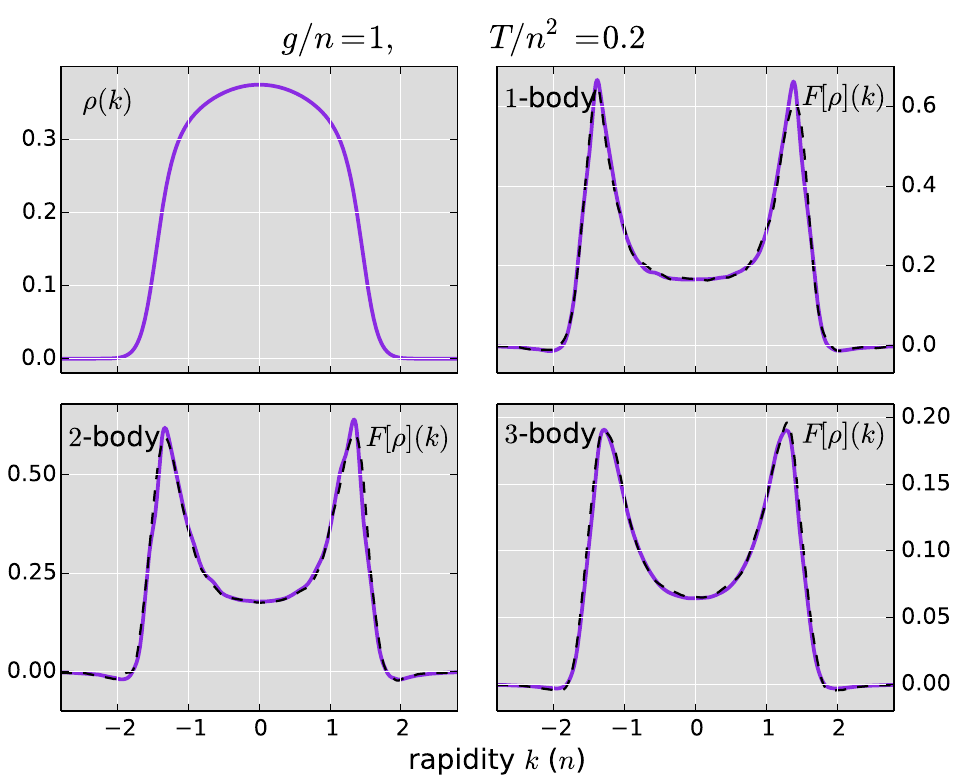
Figure 1: The rapidity distribution ρ ( k ) of the thermal state at temperature T = 0.2 n 2 , with dimensionless repulsion strength g / n = 1, is shown in the top left panel. The other three panels show the corresponding functional F [ ρ ]( k ) com- puted numerically using Eq. (8), for K = 1,2,3 respectively. The purple line is ob- tained by summing over 10 5 pairs of Bethe states with an average number of atoms N (cid:39) 30, and a smoothened density corresponding to a Gaussian convolution with width σ = 0.06 n . The black dashed line is obtained with N (cid:39) 60; it shows that the results are converged as a function of system size / atom